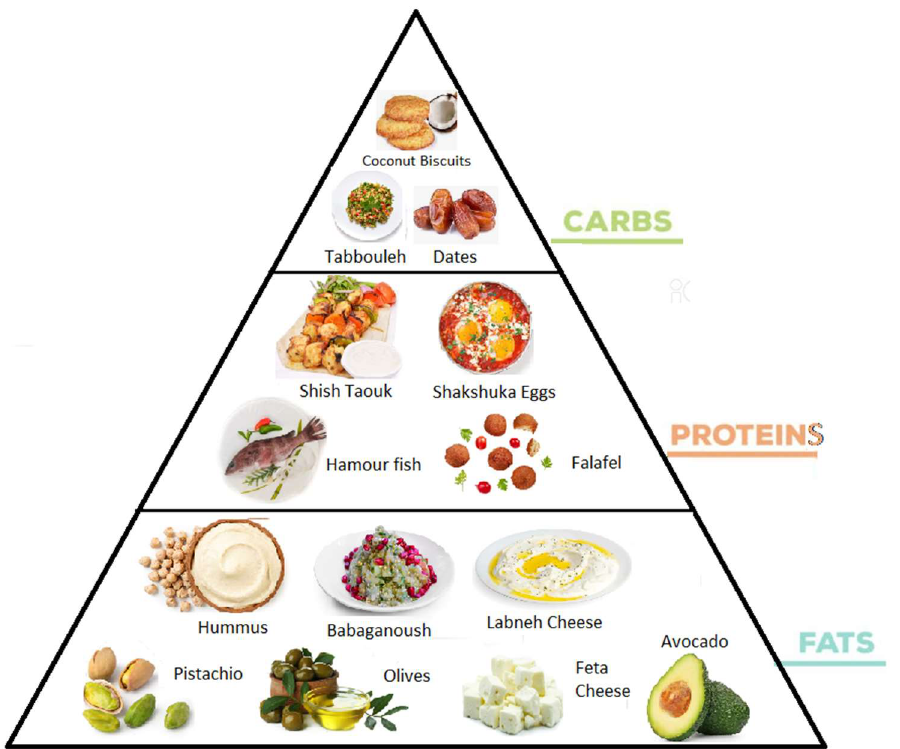
Figure 1. Ketogenic diet foods in the Middle